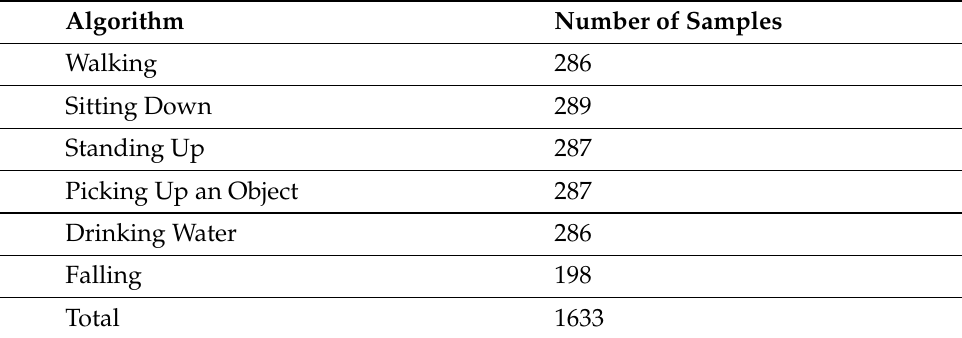
Table 1. Number of spectrograms per motion in the